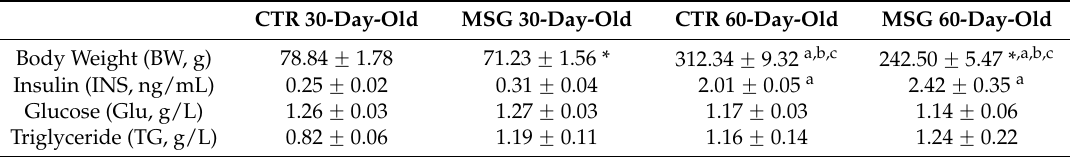
Table 2. Metabolic parameters of control (CTR) and Monosodium L -glutamate (MSG) treated